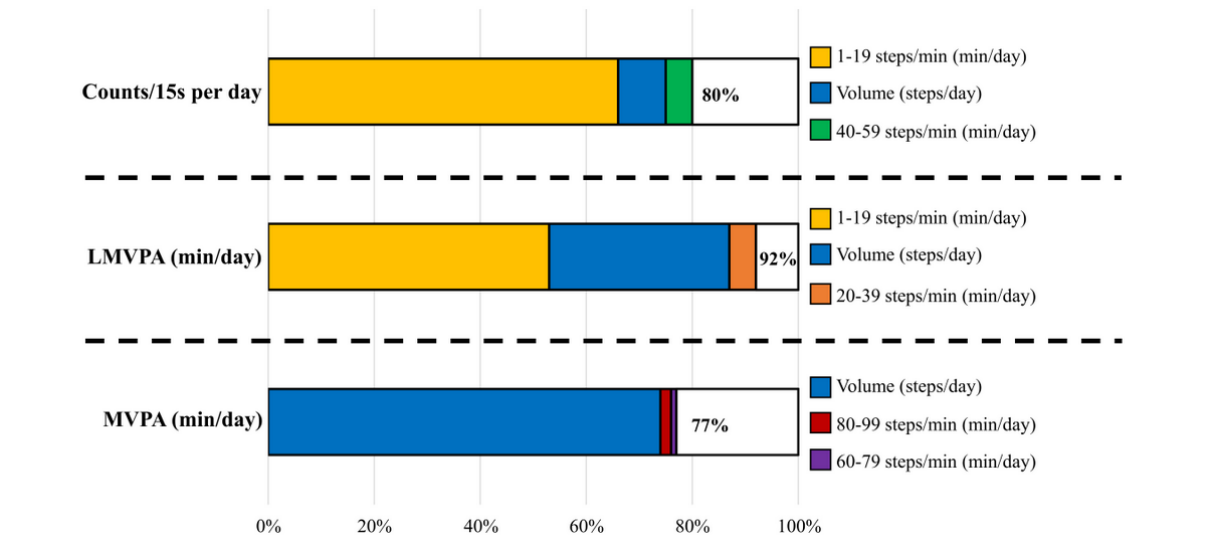
Figure 2. Proportion of variance ( r 2 ) in overall physical activity (PA) indicators (ie, counts/15 sec, light-moderate-vigorous PA [LMVPA], and moderate-to-vigorous PA [MVPA]), which is explained by a combination of step-based metrics, calculated using stepwise linear regressions. All predictors presented variance inflation factors of <6 in the selected